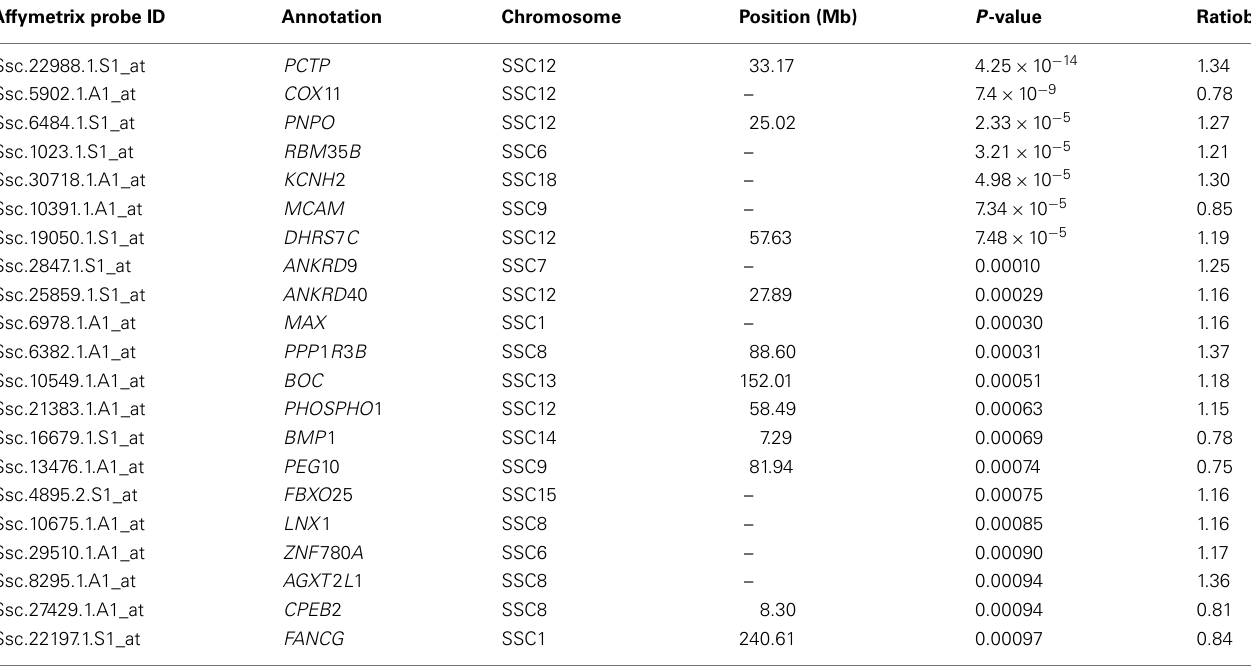
TableA9 | Differentially expressed probes conditional on copy number of PCTP